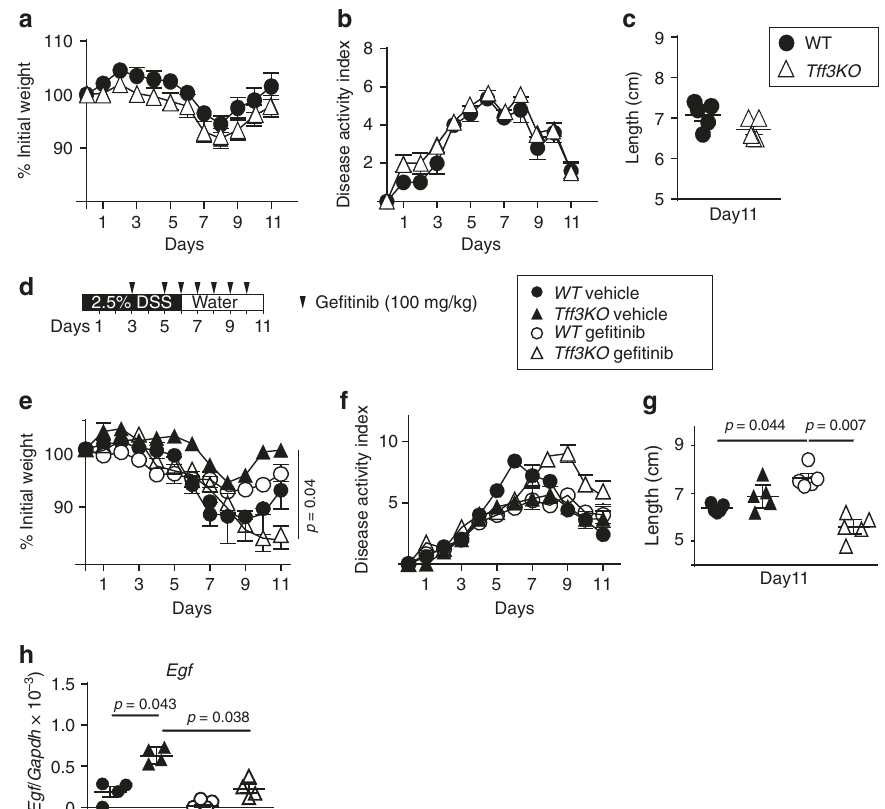
Fig. 5 TFF3 de fi ciency in mice does not increase susceptibility to DSS colitis. a Change in initial body weight, b disease activity index scores and c colon lengths following DSS administration in cohorts of co-housed WT versus Tff3 KO mice. d Ge fi tinib treatment protocol during DSS administration. e Change in initial body weight, f disease activity index, g colon lengths and h colonic Egf mRNA transcript levels at time of sacri fi ce in WT vs. Tff3 KO cohoused mice following 2.5% DSS treatment with or without Ge fi tinib. Means ± SE of 8, 9 or 10 mice/group and results of two-way ANOVA analyses are